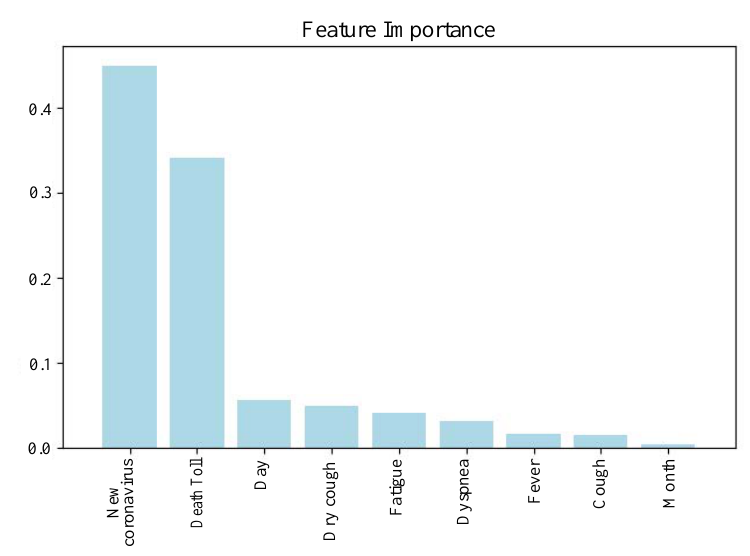
Figure 9. Feature selection results.